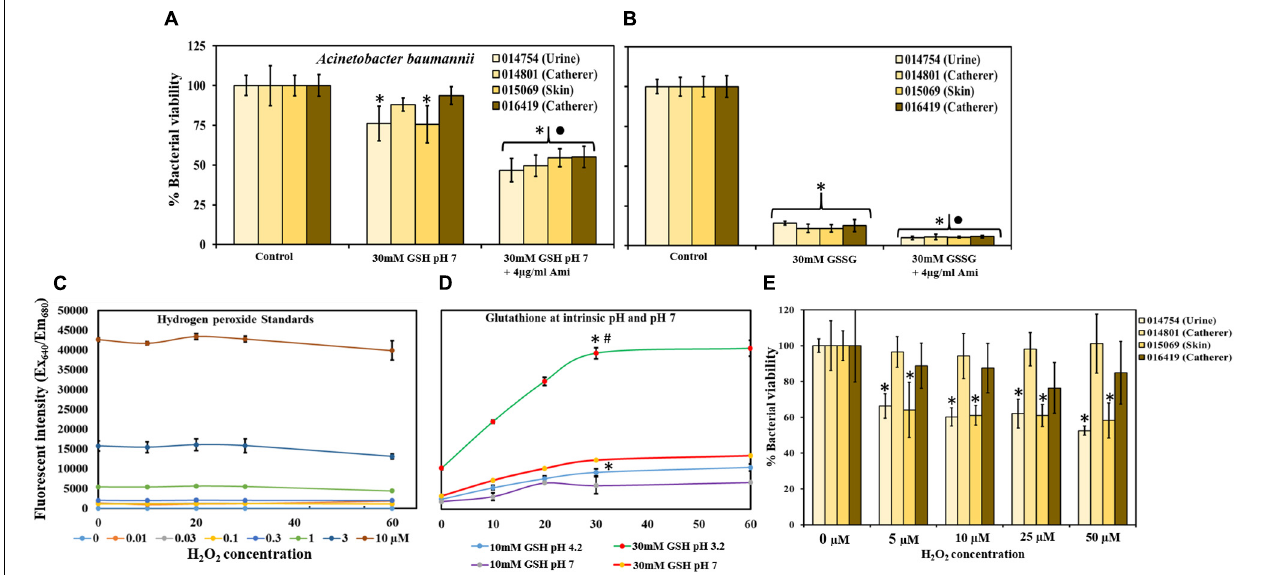
FIGURE 5 | Effect of GSH, GSSG and H 2 O 2 at neutral pH on MRAB biofilm viability. (A) 30 mM GSH (buffered to pH 7) resulted in a small biofilm viability decrease (76–94% viable), while combination with amikacin enhanced the decrease significantly (47–55% viable) when compared to both control and 30 mM GSH (pH 7) alone. (B) 30 mM GSSG alone and in combination with 4 µ g/ml amikacin significantly decreased MRAB biofilm viability to 11–14% and 5–6%, respectively, when compared to control. (C,D) Standard H 2 O 2 data used to determine H 2 O 2 production by 10 and 30 mM GSH in 1 × PBS at intrinsic pH, and at buffered neutral pH 7. At intrinsic pH, GSH produced significantly more H 2 O 2 (higher fluorescent intensity) than at its corresponding neutral pH concentration. (E) H 2 O 2 treatment showed variation in MRAB biofilm viability among isolates. When compared to control only, MRAB-1 and MRAB-3 isolates showed statistically significant decreases in biofilm viability at all H 2 O 2 concentrations. However, for MRAB-2 and MRAB-4, biofilm viability was similar to control at all H 2 O 2 concentrations. ∗ P < 0.05 compared to control • P < 0.05 when compared to 30 mM GSH (A) and 30 mM GSSG (B) and # P < 0.05 when compared to all other conditions (D) . Data represent the mean ± SD of n = 4 experiments performed in biological replicate.